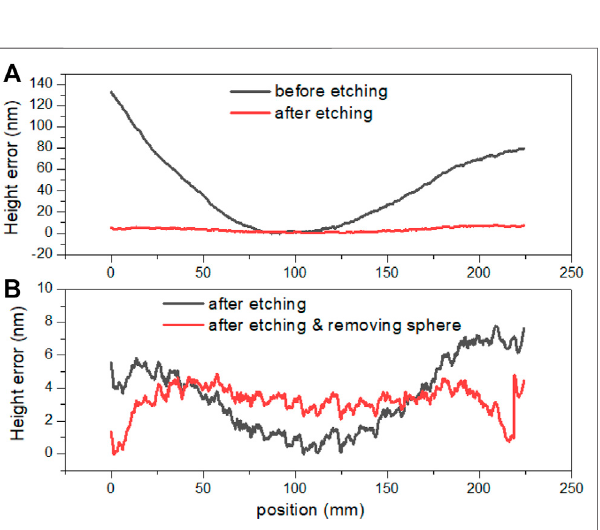
mirror. The mirror was mechanically polished previously to a fi gure of 32.7 nm (RMS) with an ultrasmooth surface (roughness < 0.3 nm). A small curvature existed in the surface pro fi le which has a best- fi t radius of 56.4 km ( Figure 2A ). If the best- fi t sphere was subtracted, the residual fi gure error before IBF is 13.2 nm (RMS) ( Figure 2B ). The mirror surface pro fi le (including the 2nd order spherical error) was fi gured by two iterations. After that, the radius of the best- fi t sphere was increased to 603 km with a fi gure of 2.7 nm RMS ( Figure 2C ). Due to the small mirror thickness, it is dif fi cult to completely remove the 2nd order curvature, and this extremely large radius of curvature will have negligible effect for application in the beamline. The residual height error after subtraction of the best- fi t sphere was only 1.2 nm (RMS) ( Figure 2D ). The one-dimensional height pro fi le along the length direction at the center area of the mirror is shown in Figure 3A . The height error (including the 2nd order curvature) decreased dramatically from 132.9 to 7.8 nm